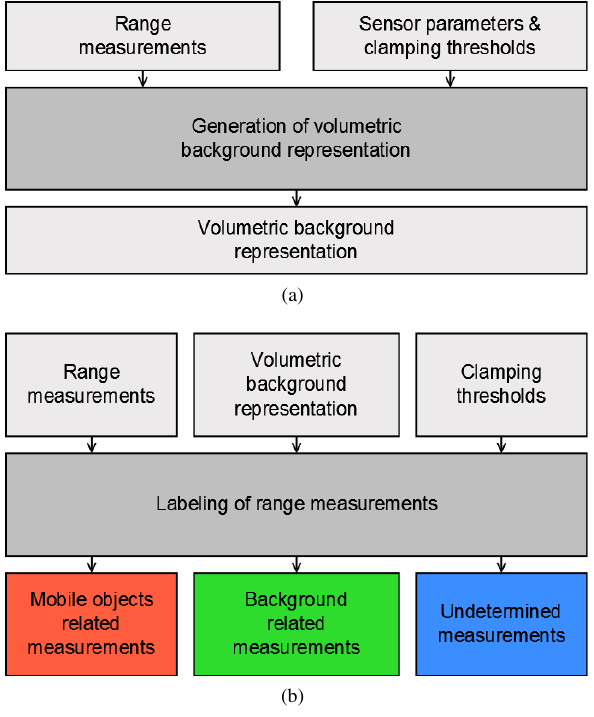
Figure 3. Illustration of the two-stage process for labeling range measurements. (a) Generation of the background representation. (b) Labeling of range